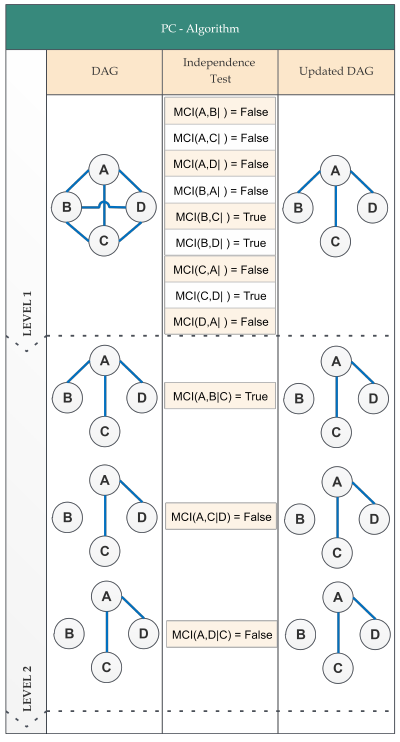
Figure A1. Example of applying PC algorithm in a hypothetical dataset [40].